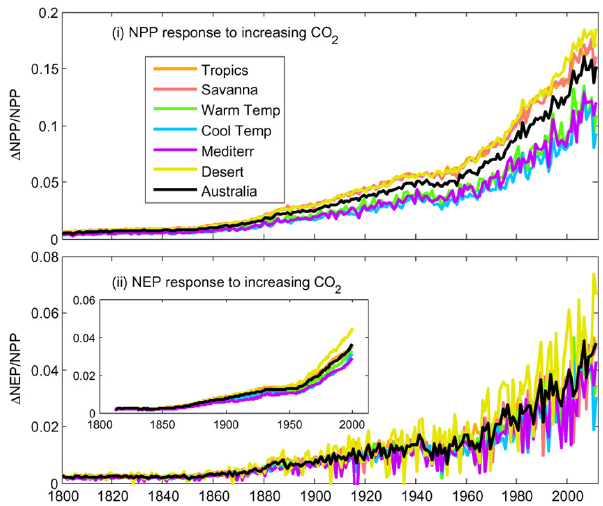
Fig. 9. (i) Response of NPP to increasing CO 2 , calculated as the dif- ference between NPP simulated with rising CO 2 and pre-industrial CO 2 (280ppm), relative to NPP simulated with pre-industrial CO 2 ; (ii) response of NEP to increasing CO 2 , calculated as the difference between NEP simulated with rising CO 2 and pre-industrial CO 2 , relative to NPP simulated with pre-industrial CO 2